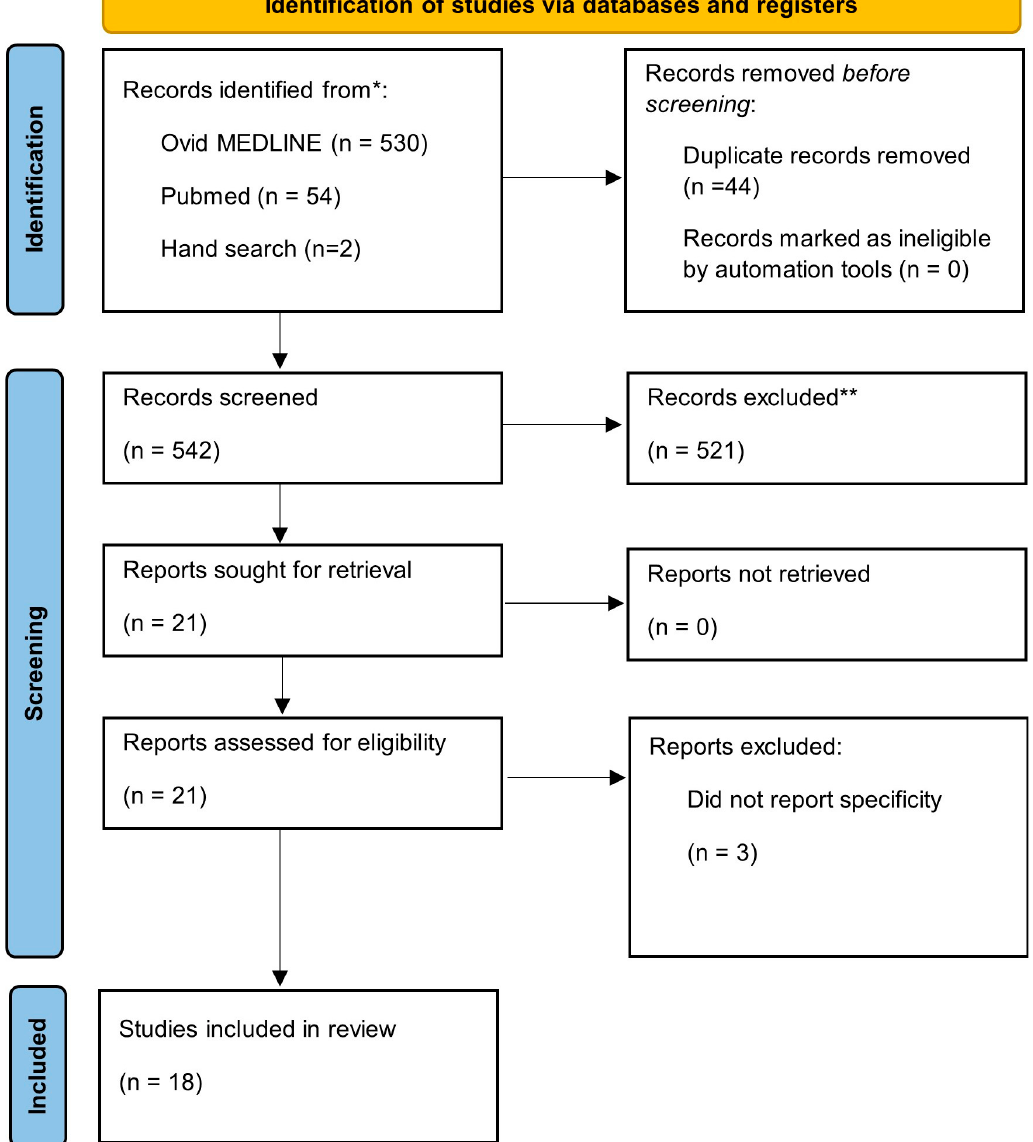
Figure 1. PRISMA flow diagram illustrating the study selection process. * All of the records identified from initial literature search; ** not relevant or did not have a control group or commentaries or abstract publication only. Table 1. Basic characteristics of the studies for volatile organic compounds in the detection of hepatobiliary and pancreatic cancer and their true positive (TP), true negative (TN), false positive (FP), and false negative (FN) values.